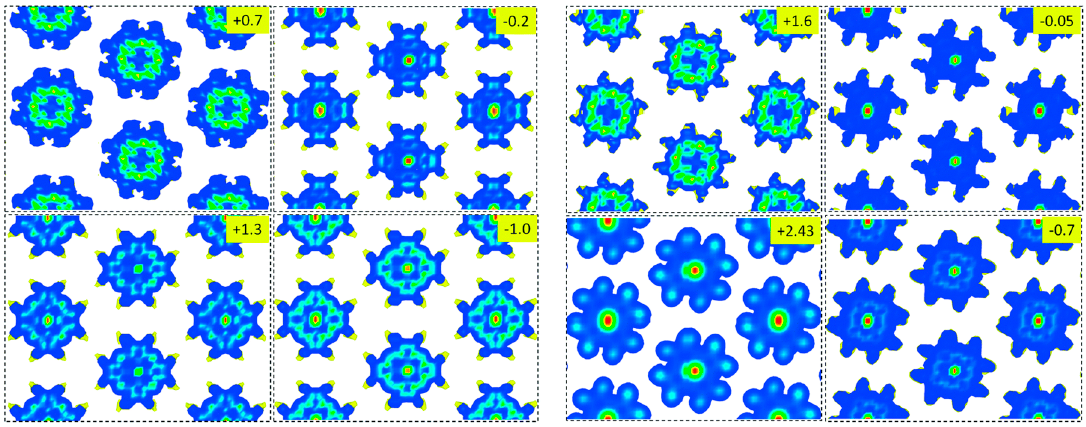
Figure 7. PDFT simulated bias-dependent STM images of Cobalt Octaethylporphyrins (OEP) on Au(111) and HOPG surfaces. Reproduced from reference [96] published by the PCCP Owner Societies.